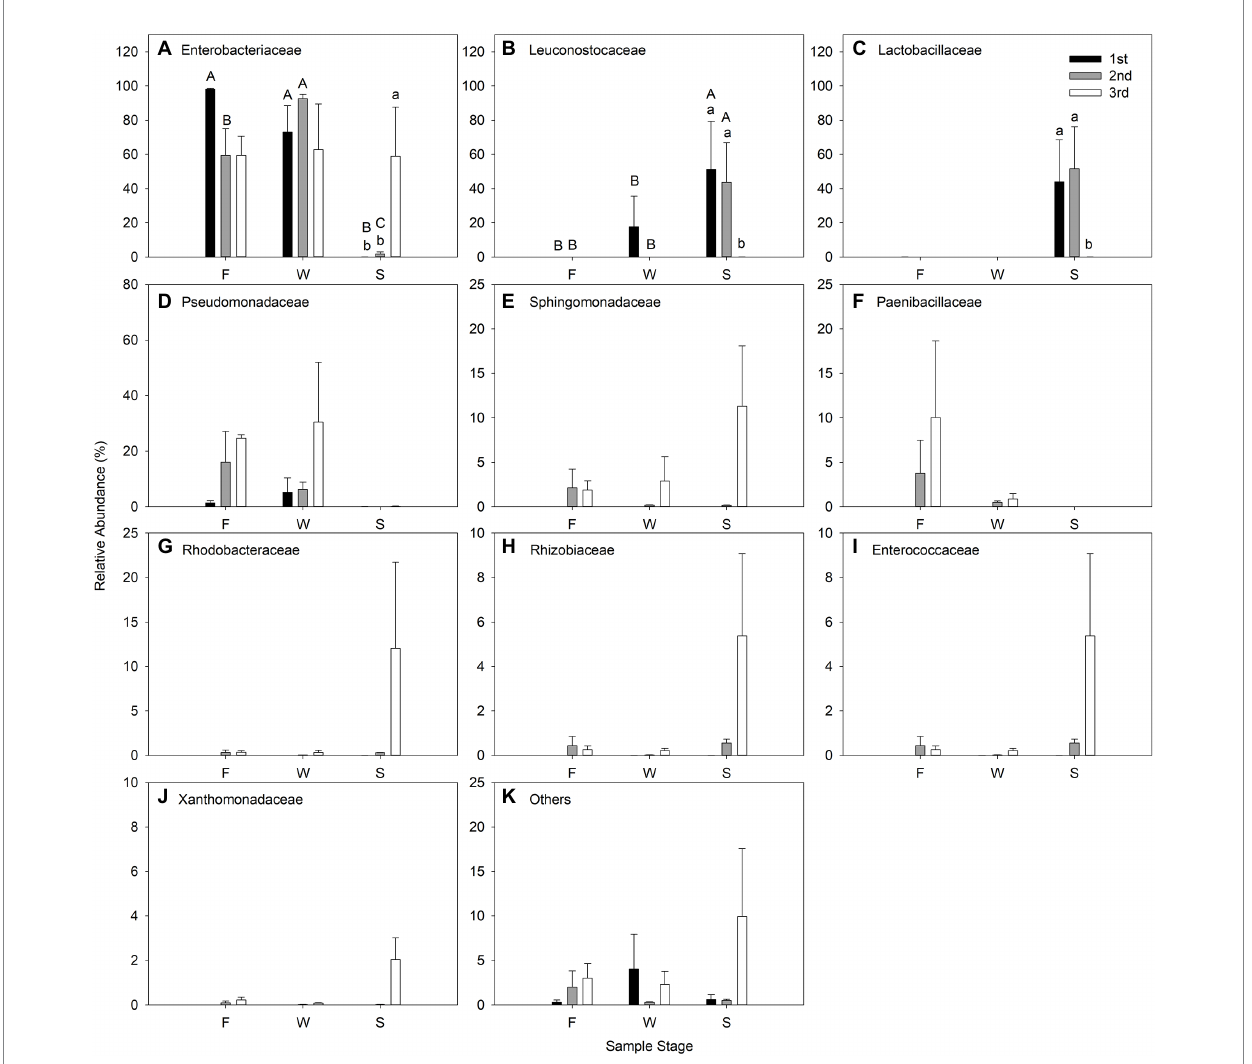
FIGURE 5 Relative abundance (% of individual taxonomic group) of dominant bacteria family (mean ± SE, n = 3) in microbial communities following fresh alfalfa (F), wilted alfalfa (W) and ensiled alfalfa (S) at different cuttings. The black filled bar indicate the first cutting alfalfa, the gray filled bar indicted the second cutting alfalfa, and the non-filled bar indicate the third cutting alfalfa. Bar with different capital letters differ among F, W, and S in the same cutting; Bar with different lowercase letters differ among different cuttings p =